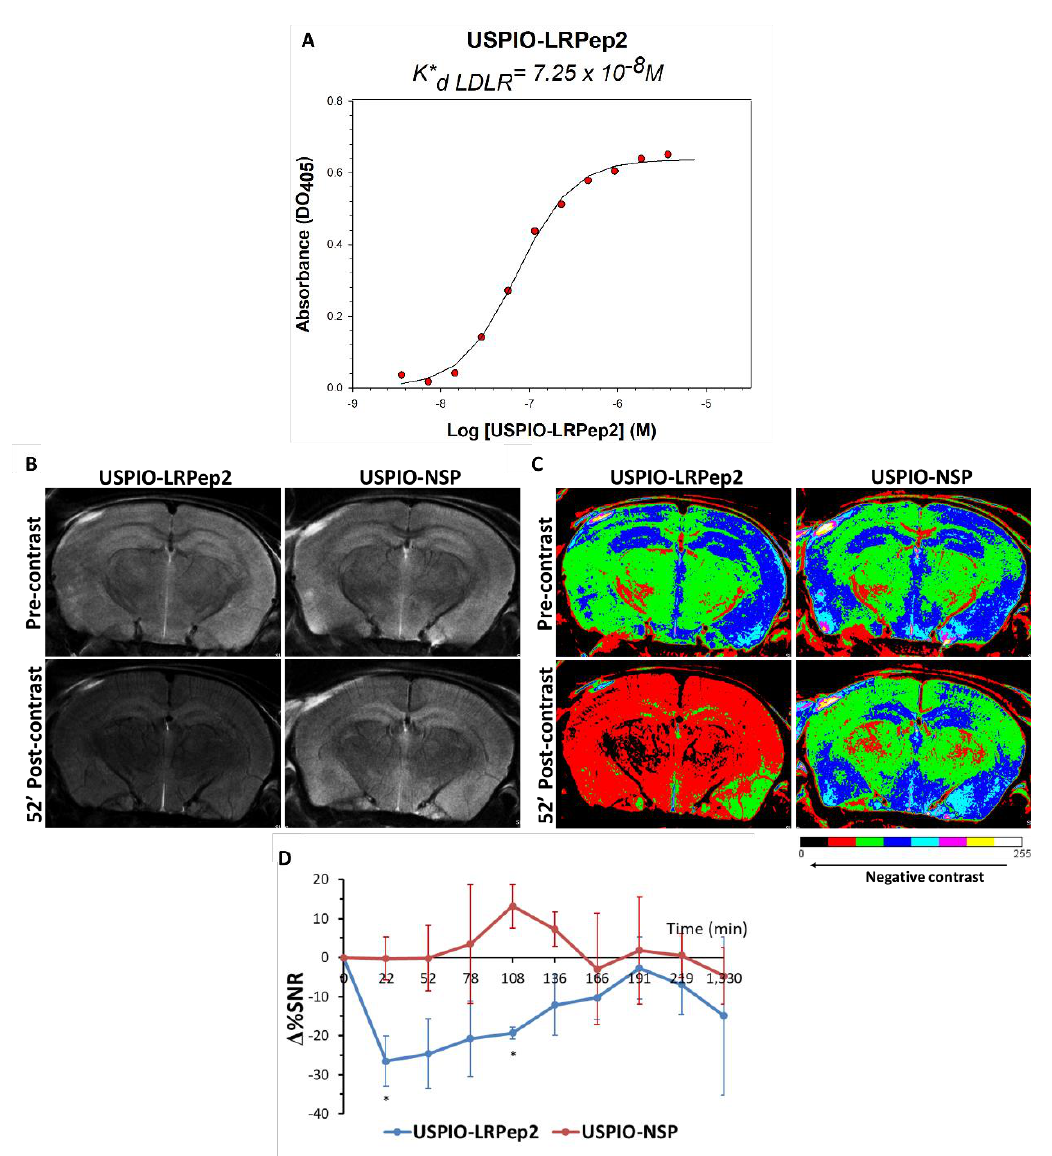
Figure 7. ( A ) The apparent dissociation constant (K* d ) of ultrasmall superparamagnetic particles of iron oxide (USPIO)-LRPep2 for LDLR. The inflection point of the curve corresponded to the apparent dissociation constant (K* d ) of USPIO-LRPep2 for the binding to LDLR, and the strength of the affinity was inversely proportional to the K* d value. ( B – D ) In vivo evaluation of the blood-brain barrier (BBB) crossing ability of USPIO-LRPep2 by MRI. ( B ) Representative raw coronal MRI images of the brains (bregma: − 1.64 mm) of NMRI (Naval Medical Research Institute) mice acquired with the rapid acquisition with relaxation enhancement (RARE) protocol (spatial resolution = 48 µm) before (pre-contrast) and 52 min after injection of USPIO derivatives (post-contrast). Accumulation of USPIO derivatives (negative contrast agents) led to the darkening of the brain tissue. ( C ) Color overlay images, allowing to better visualize the negative contrast produced by USPIO, which is directly proportional to the red and black pixels. ( D ) Analysis of the percentage change of signal-to-noise ratio ( ∆ %SNR) produced by USPIO on MRI images of the brain, measured by the ImageJ software. A decreased ∆ %SNR corresponded to the negative contrast generated by USPIO derivatives. *: p < 0.05.